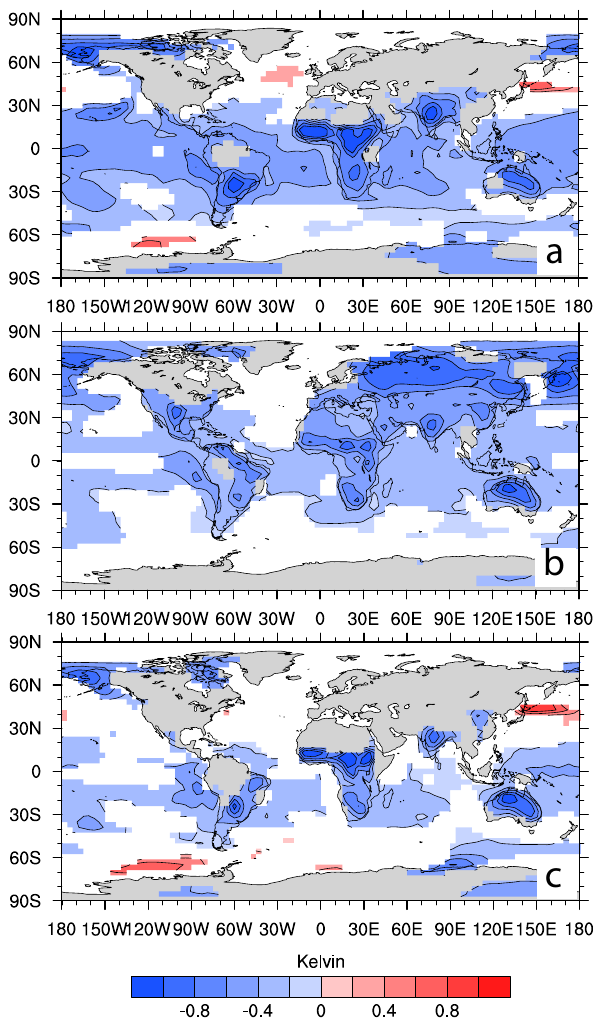
Fig. 2. (a) Ensemble mean of 2m temperature differences, aver- aged over the 1805–1825 period for the ALL run. (b) Same for the “Bottom-Up” run. (c) Same for the VOLC run. Only areas that are significant at the 5% level are colored (two-sided t